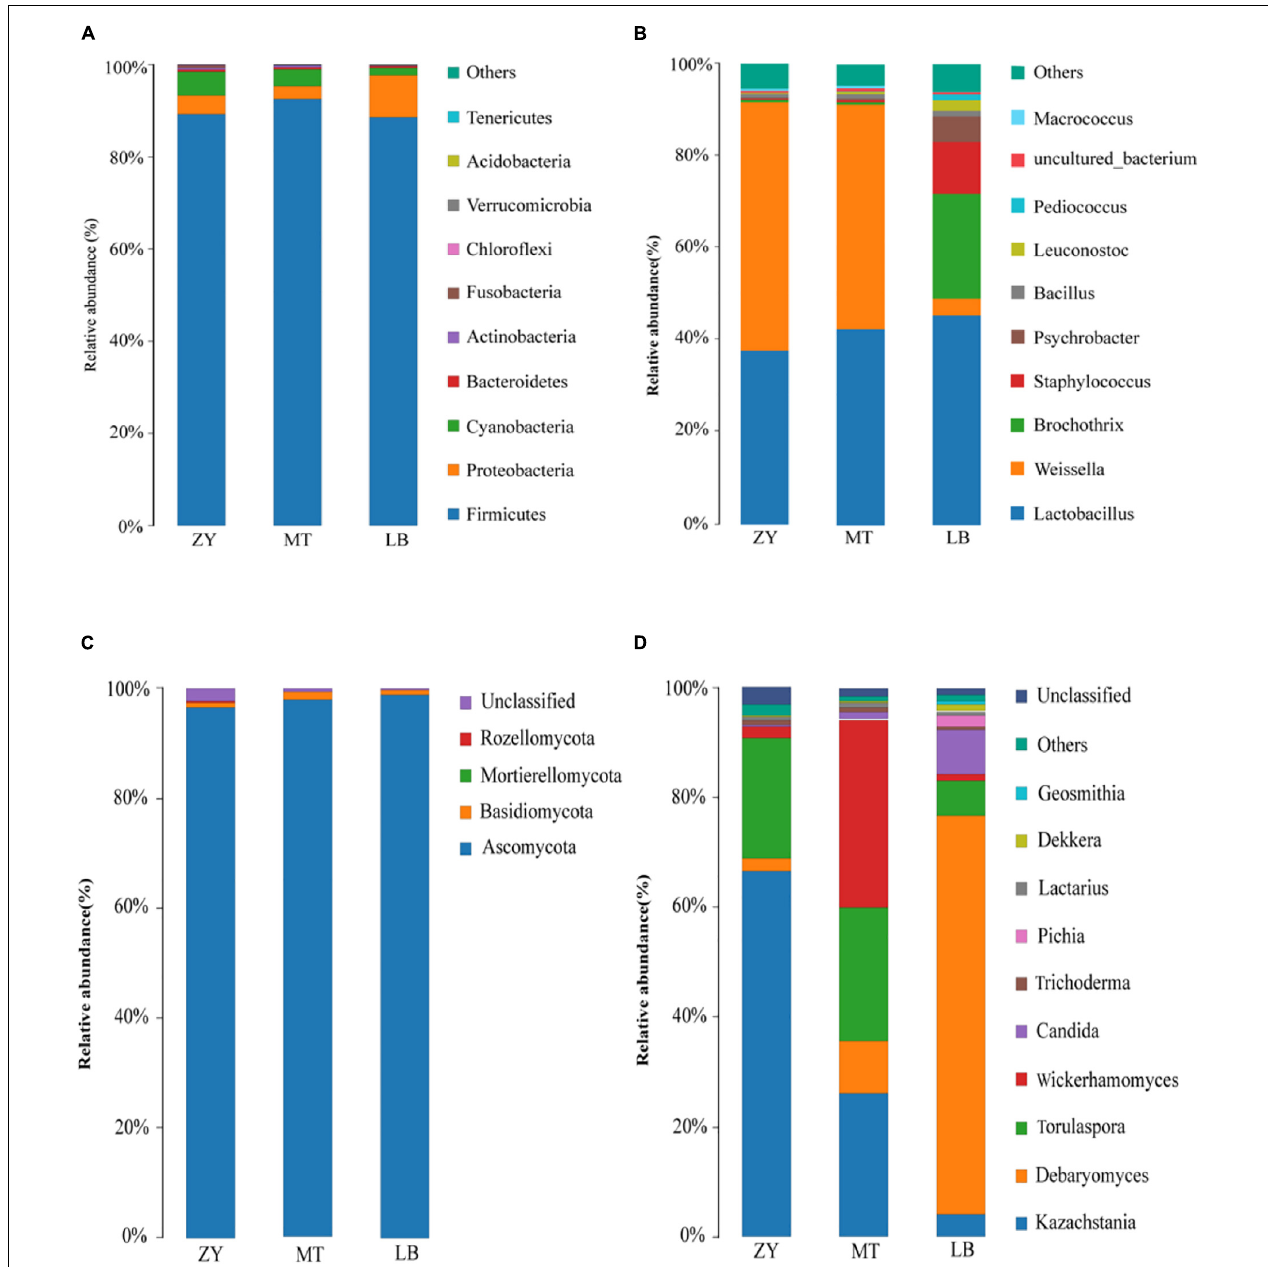
FIGURE 2 | Relative abundance of bacteria at the phylum (A) and genus (B) level and fungi at phylum (C) and genus (D) of SZR from different